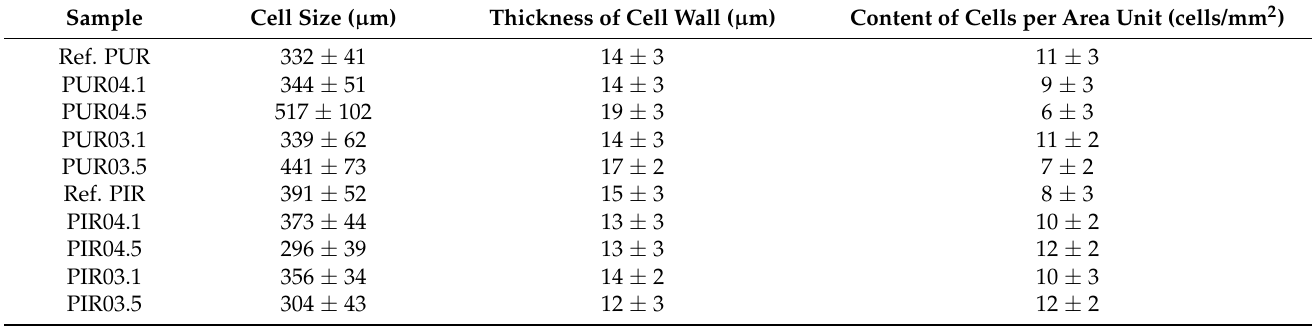
Table 7. Results of SEM micrographs’ analysis.